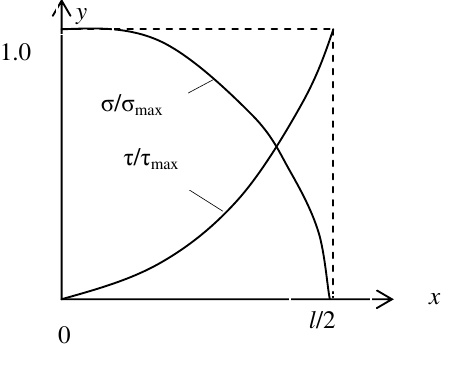
Fig 3 . Distribution of traction and shear stresses along the